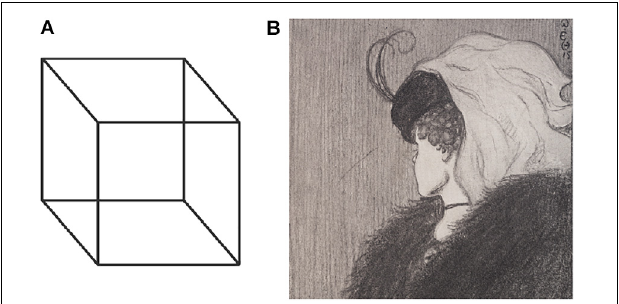
FIGURE 1 | Ambiguous images: (A) the Necker cube, (B) My Wife and My Mother-in-Law.